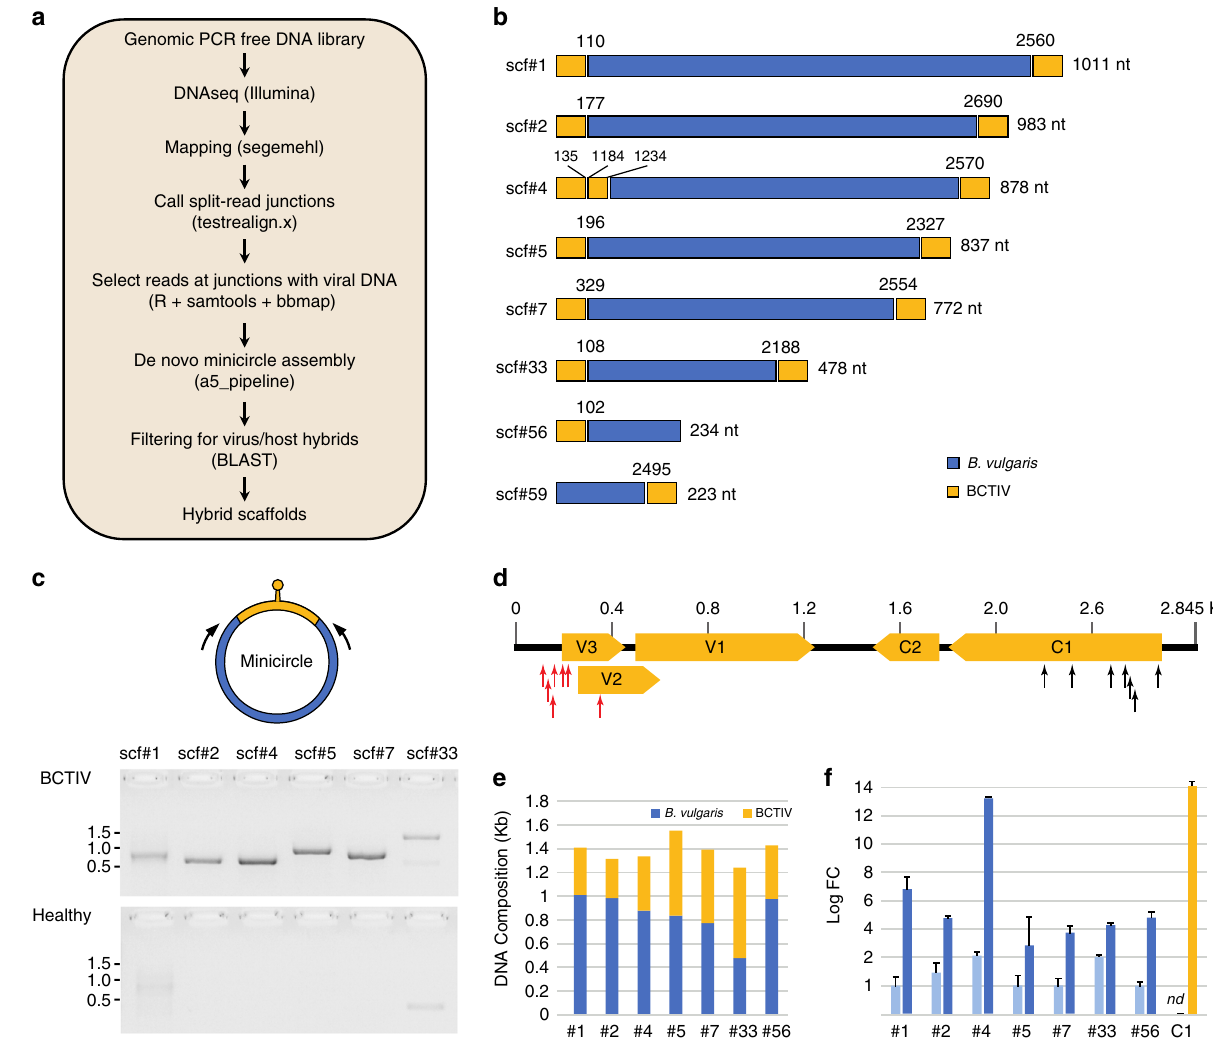
Fig. 2 Identi fi cation of minicircles in experimentally infected Beta vulgaris plants by the NGS approach. a Diagram of the bioinformatic pipeline used for the detection of minicircles. The tools used in each step are indicated in parentheses (refer to the Methods section for details). b Schematic representation of the eight BCTIV/ Beta vulgaris hybrid scaffolds assembled after the fi ltering step described in a . The junction coordinates referring to the BCTIV genome are indicated above each recombination point. The sizes (nt) of the B. vulgaris DNA fragments (blue portions) are reported on the right. c In vivo validation of the circular nature of the scaffolds reported in b , performed by inverse PCR (see also Supplementary Figure 3). The approximate positions of the primers speci fi c for the non-viral portions of each minicircle (in blue) are indicated by arrows. DNA from mock-inoculated B. vulgaris was used as a negative control. Molecular markers (kb) are shown on the side. Source data are provided as Supplementary Data 5. d Distribution of minicircle junctions between viral and host DNA. The proximal and distal junctions are marked with red and black arrows, respectively. BCTIV ORFs are represented by yellow boxes. e Relative contributions of B. vulgaris and BCTIV DNA to minicircles identi fi ed by NGS. f Relative increase in copy number of chromosomal DNA fragments due to their ampli fi cation as parts of minicircles in the BCTIV-infected plant. Copy number was determined by quantitative PCR and normalized to a single copy gene (GAPDH). Light-blue bars represent healthy plants and dark-blue bars BCTIV-infected plants. BCTIV copy number was estimated by ampli fi cation of a fragment of the C1 ORF (yellow bar). Each bar represents the mean of three repetitions; ±s.d. marked by error bars; nd not detected. Source data